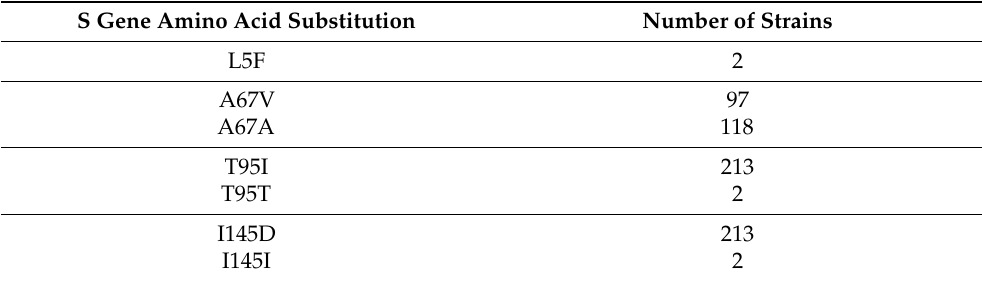
Table 2. Mutations registered in two or more BA.1 genomes from St.